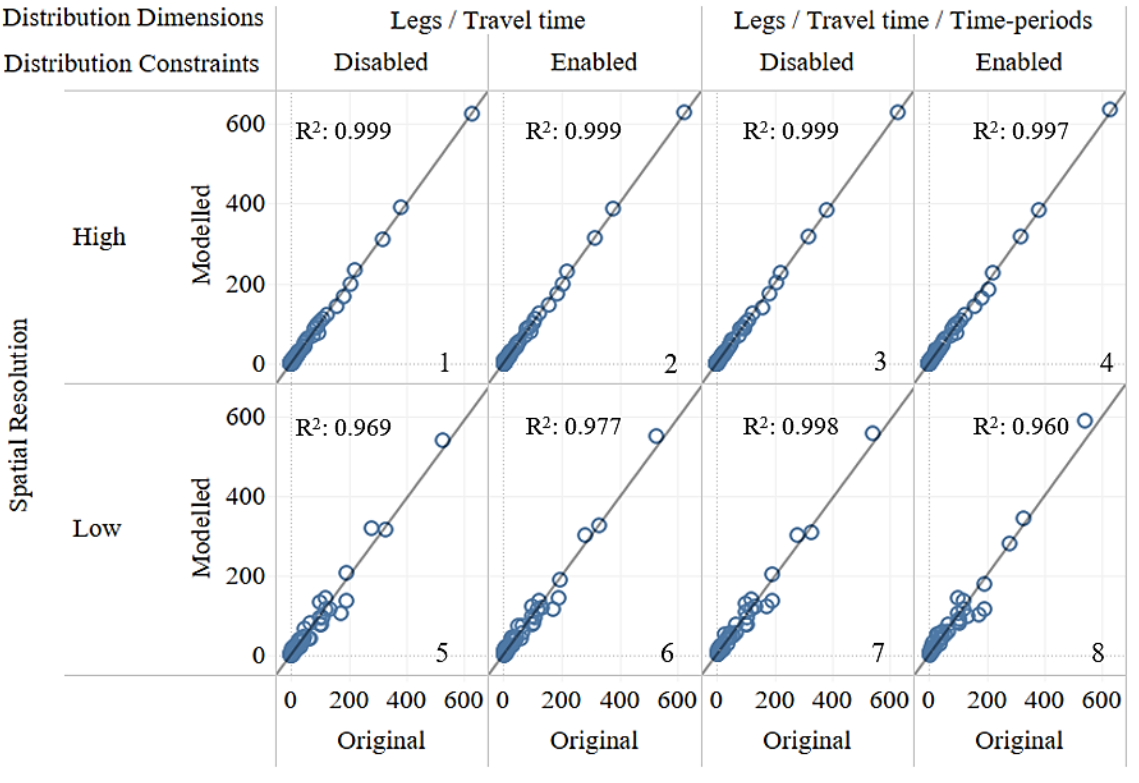
Figure 9. Comparison of departures time period between original and modelled